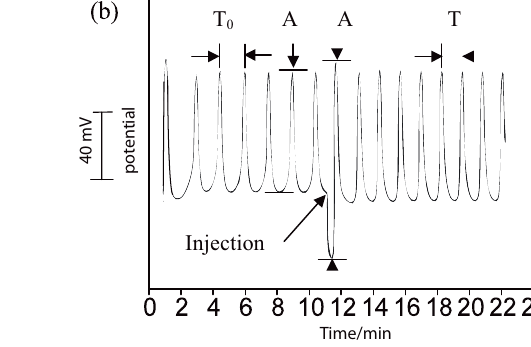
] = 0.018 M; [malic acid] = 0.195 M; 3